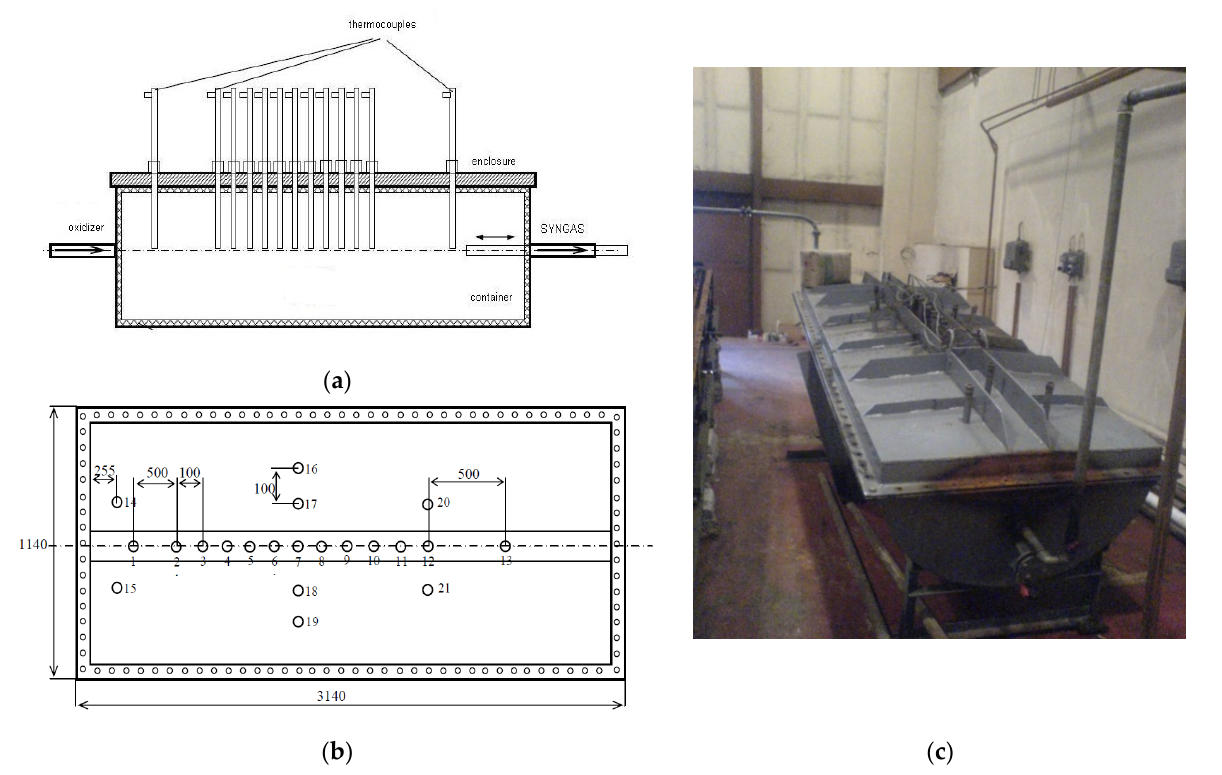
Figure 2. Scheme ( a ), parameters top view ( b ), and real view ( c ) of UCG generator (ex-situ reactor).